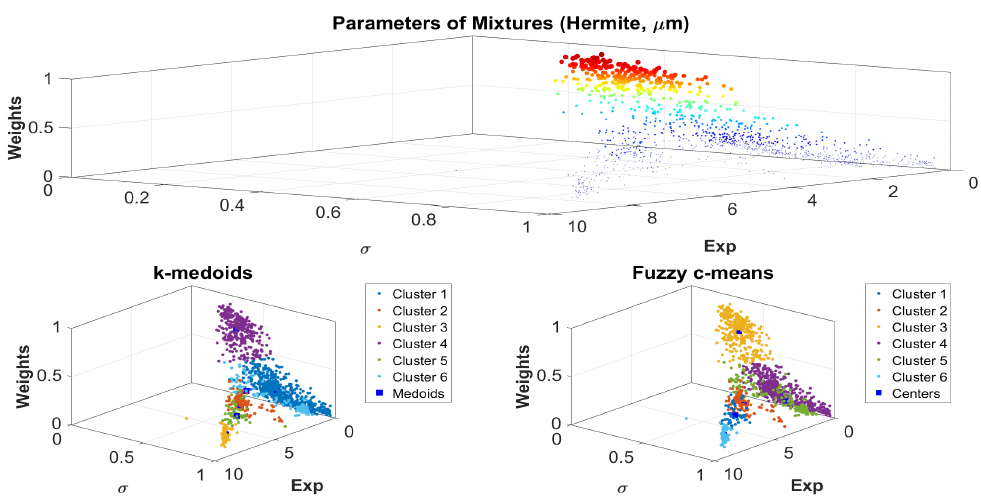
Figure A27. Clustering the mixture parameters (bootstrap, µ m),